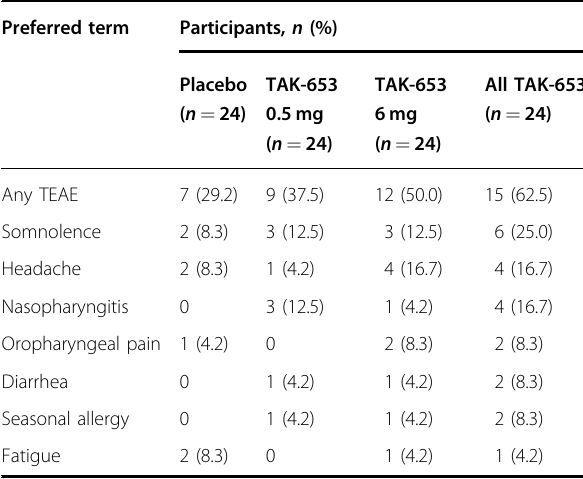
Table 2 Most frequent TEAEs ( ≥ 5% of individuals in placebo or overall TAK-653).